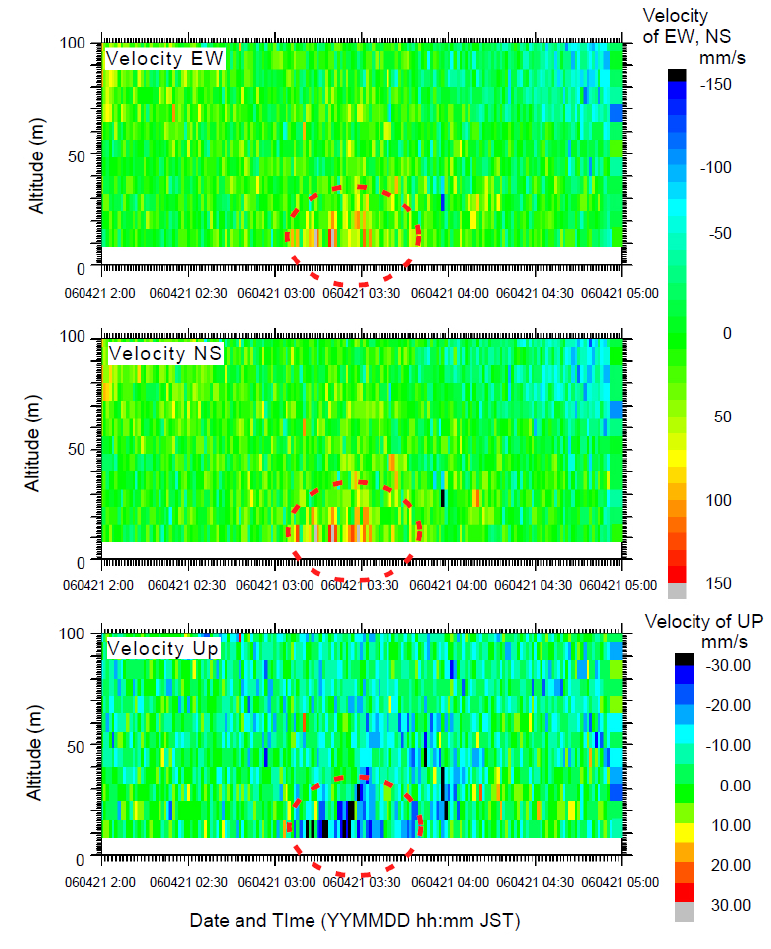
Figure 9. Three components of the current velocity time variations obtained using the ADCP sensor. The current direction changed downward and northeastward at 3:10. The mudflow thickness was estimated as about 30